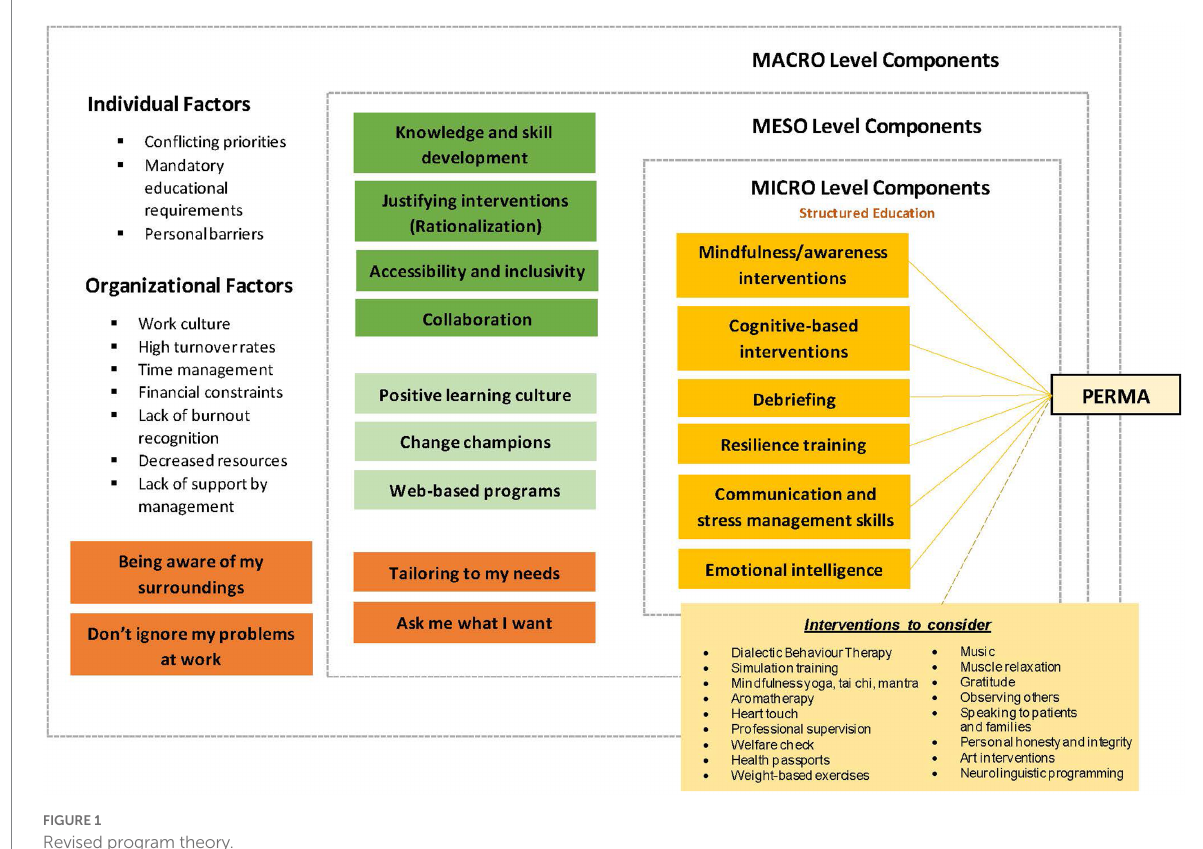
FIGURE 1 Revised program